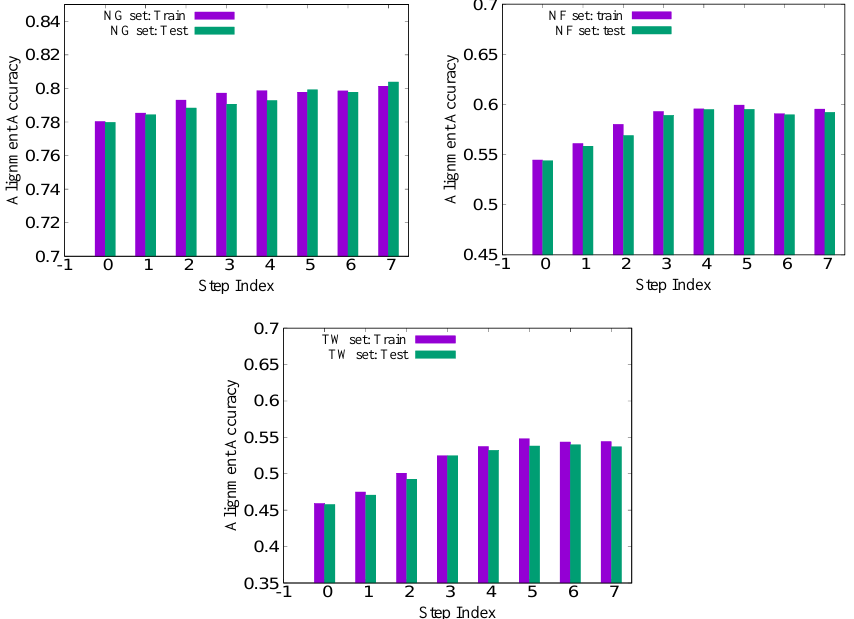
Figure 3. Training and test accuracies for the Viterbi alignment on the three sets NG ( top left ), NF ( top right ) and TW ( bottom ) of 200 reference alignments from SABmark. Note that we are using the three-state scheme here.